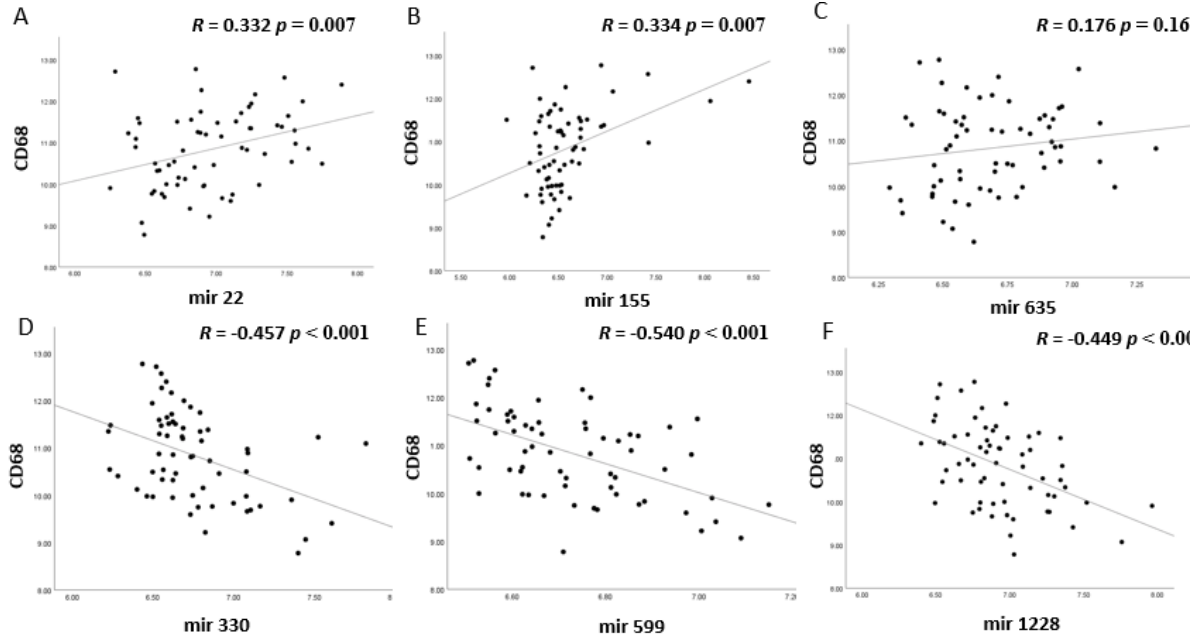
Figure 5. The expression levels of six different miRNAs ( A – F ) were compared to the mRNA levels of CD68, a macrophage marker, in 64 Uveal Melanoma from Leiden. p values were determined using Spearman correlation. p ≤ 0.05 was considered significant. ( A ) miR-22, ( B ) miR-155, ( C ) miR-635, ( D ) miR-330; ( E ) miR-599; ( F ) miR-1228 versus CD68